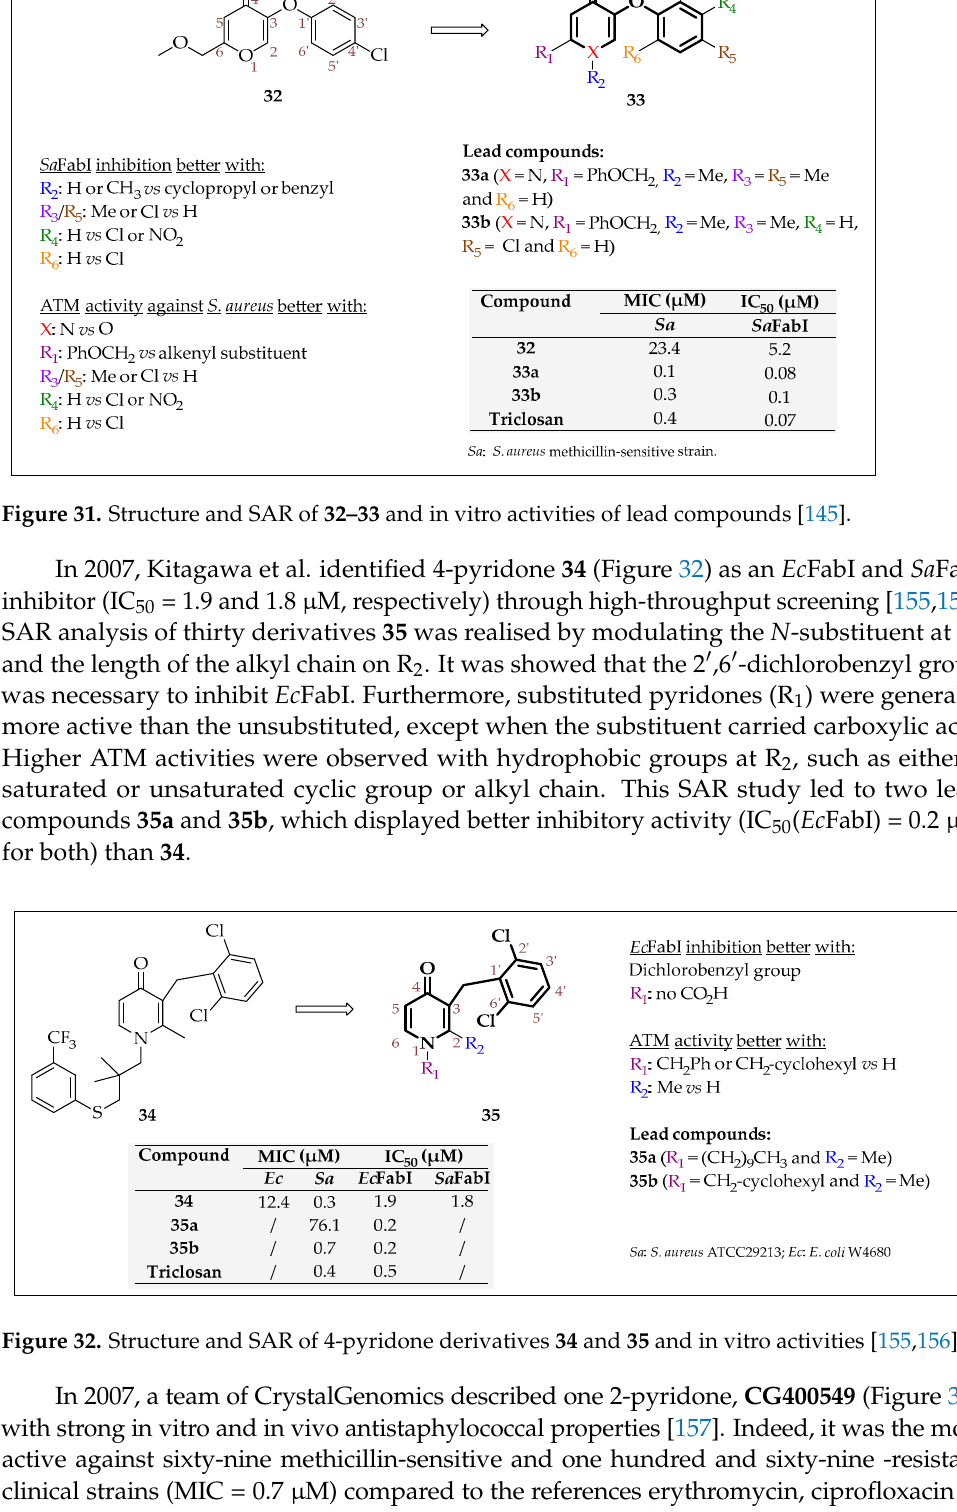
29 of 49 Figure 30. Structure, representation of the main interactions with Mt InhA and in vitro activities of INH and its active form bound to NADH [7,47,126]. Thanks to a high-throughput screening, Kim et al. identified phenoxypyrone 32 (Fig- ure 31) as an interesting Sa FabI inhibitor (IC 50 = 5.2 µM) [145]. To increase its inhibitory and ATM activities, fifty-one derivatives 33 (Figure 31) were developed by modulating the substituents of both rings. To improve the solubility and the physico-chemical prop- erties of their compounds, 4-pyrone ring was replaced by 4-pyridone. SAR study showed that 4-pyridone with (i) phenoxymethyl substituents at position 6 (R 1 ) lowered the MIC